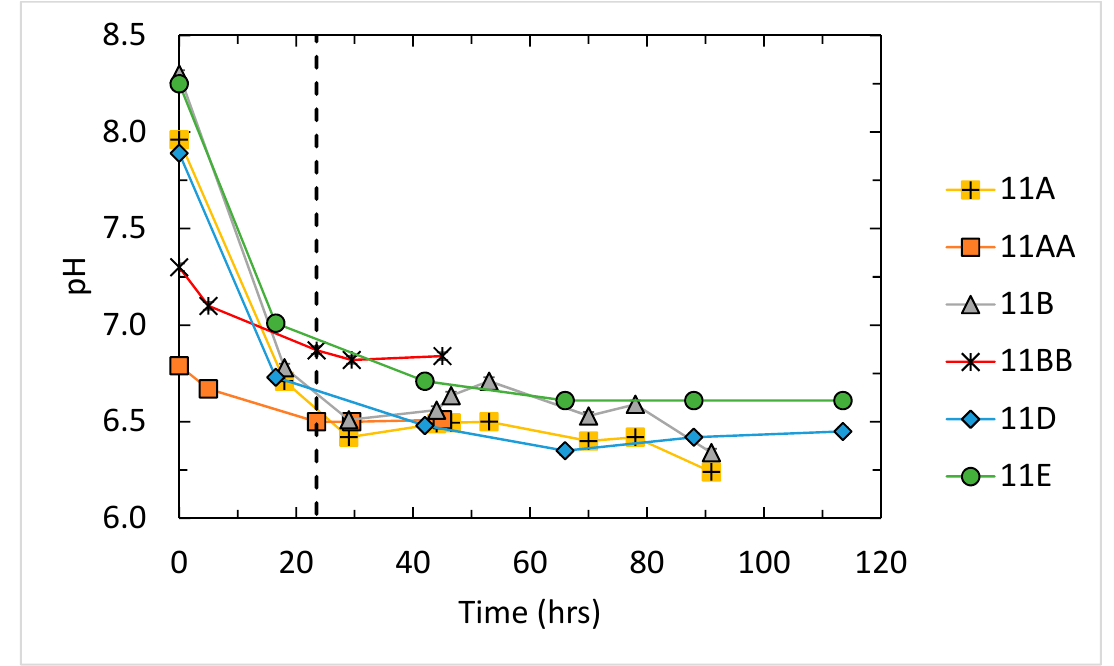
Figure 4. Graphical representation of pH plotted against time for experiments 11A through 11E. The analytical uncertainty was ± 0.02, and is included in symbol size. The vertical dashed line indicates the observed onset of crystallization at approximately 24 h.